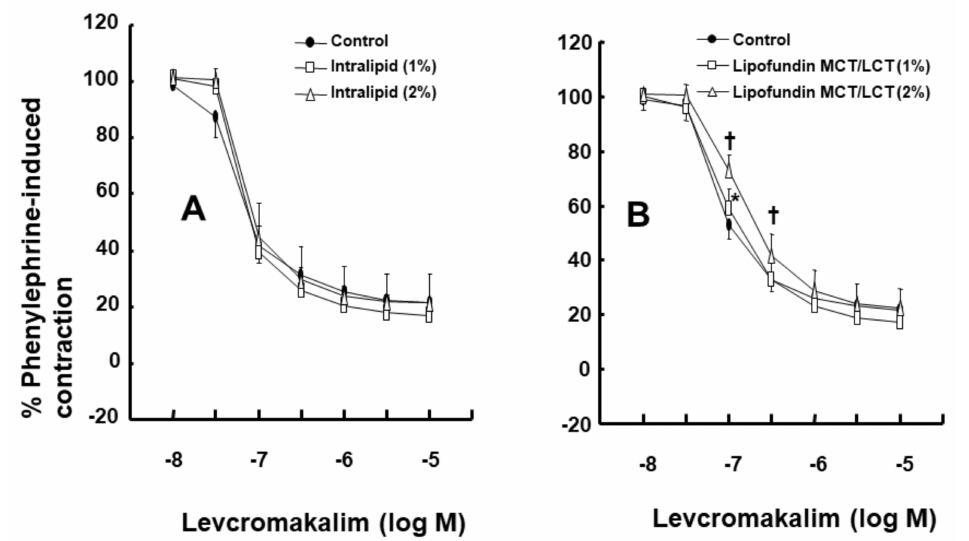
Figure 1. E ff ect of Intralipid ( A , n = 9) and Lipofundin MCT / LCT ( B , n = 9) on levcromakalim-induced vasodilation in endothelium-intact rat aortae. Data are shown as the mean ± SD and expressed as the percentage of the maximal contraction induced by phenylephrine (10 − 6 M). N indicates the number of isolated rat aortae. * p < 0.05 and † p < 0.001 versus